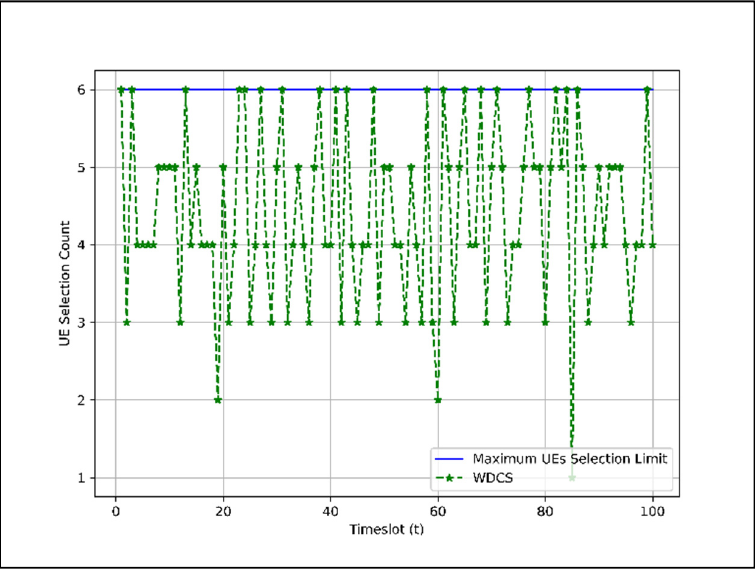
Figure 10. Total UEs selection count under WDCS for 100 timeslots.